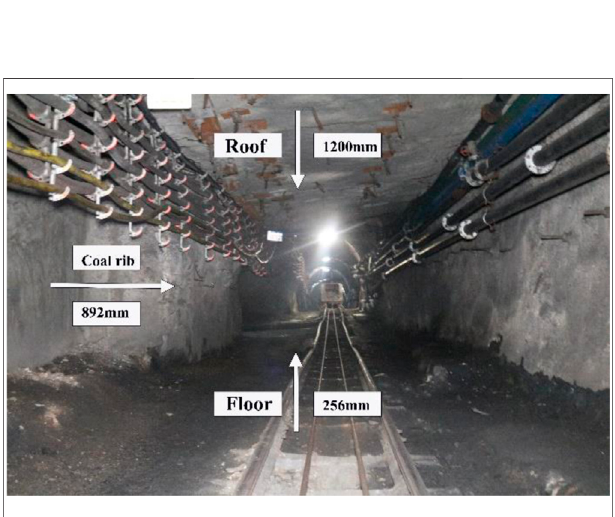
FIGURE 4 | Field monitoring and observation of ground